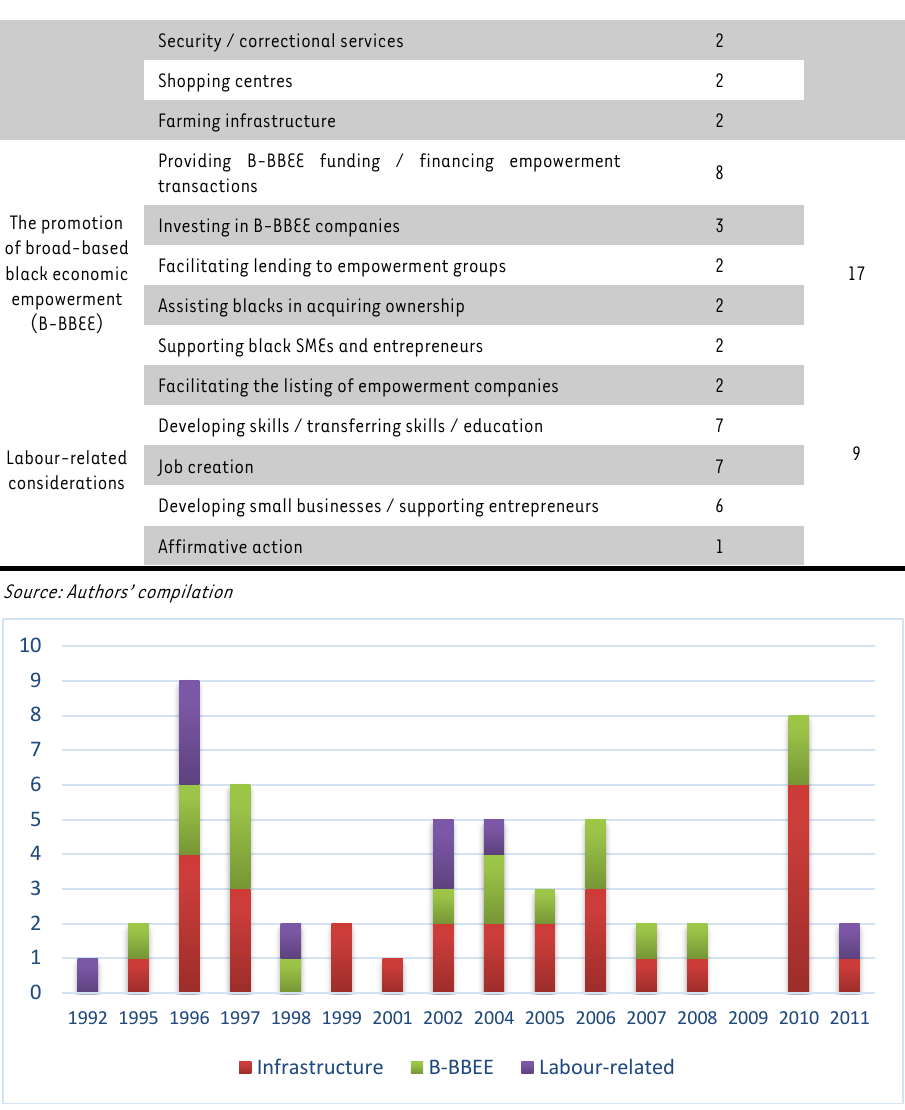
FIGURE 2: Social criteria employed by RI funds over the period 1 June 1992–31 December 2012